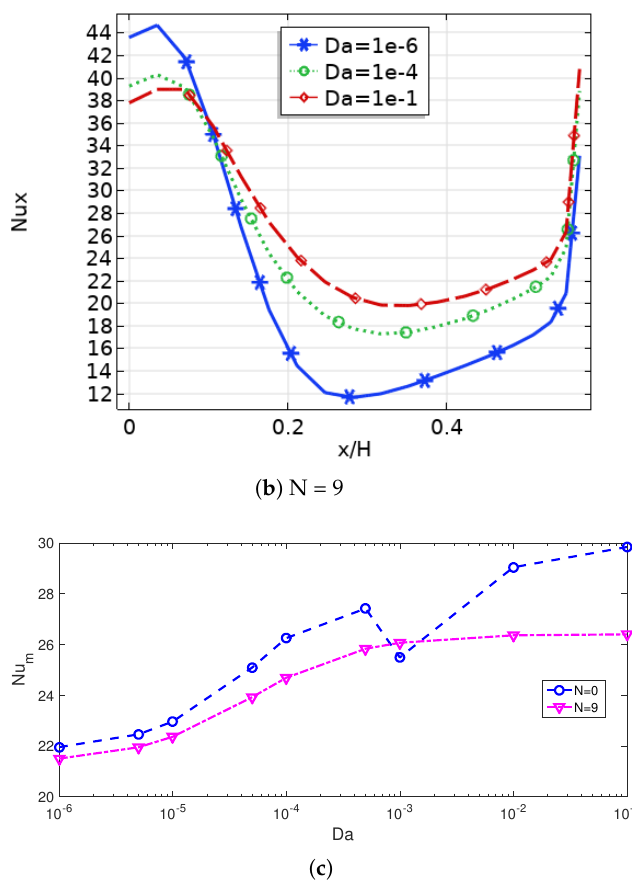
Figure 13. Impacts of Da on the variation of local ( a , b ) and average Nu ( c ) for the cases without plate (W) and with PPP (Re = 800, Ha = 15, Ca = 10 − 5